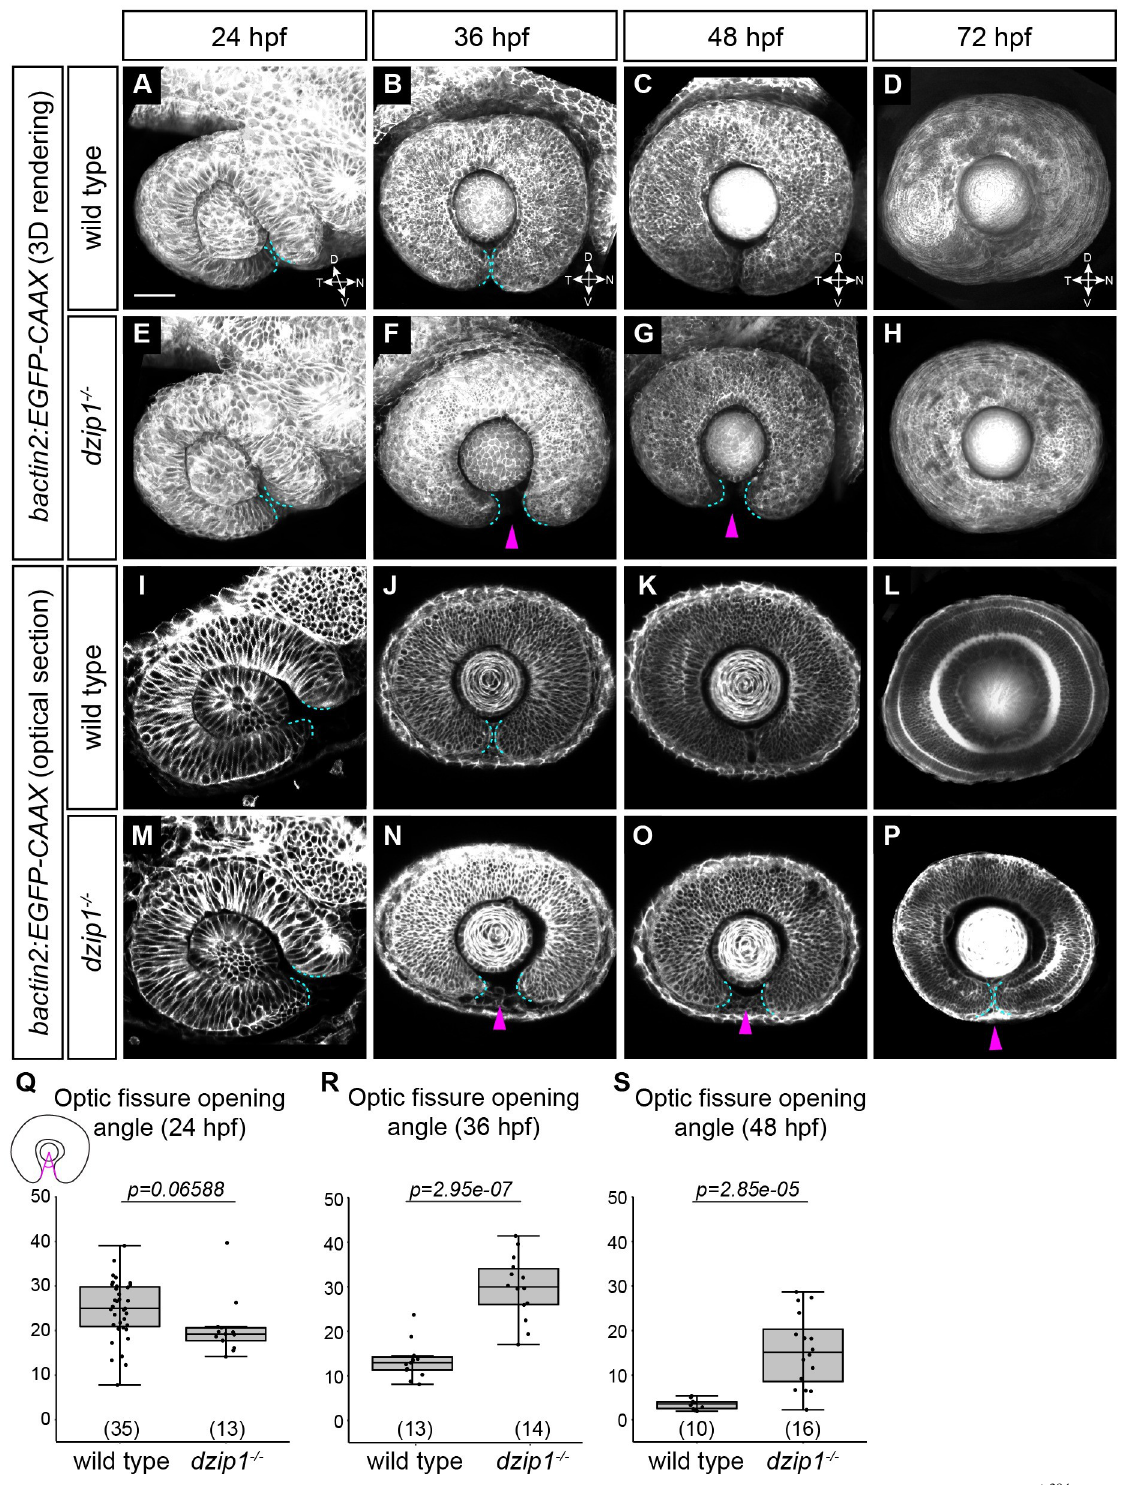
Fig 2. dzip1 mutants show defects in optic fissure closure but not optic fissure formation. (A-P) Wild type (A-D, I-L) and dzip1 ts294e mutants (E-H, M-P) visualized for membranes ( Tg(bactin2 : EGFP-CAAX) ) at 24 hpf (A, E, I, M), 36 hpf (B, F, J, N), 48 hpf (C, G, K, O), and 72 hpf (D, H, L, P). (A-H) Images are lateral views of 3-dimensional renderings. (I-P) Images are lateral views, optical sections from 3-dimensional datasets at the proximal-distal midpoint of the lens. Cyan dashed lines in A-P outline optic fissure margins. At 36 hpf and 48